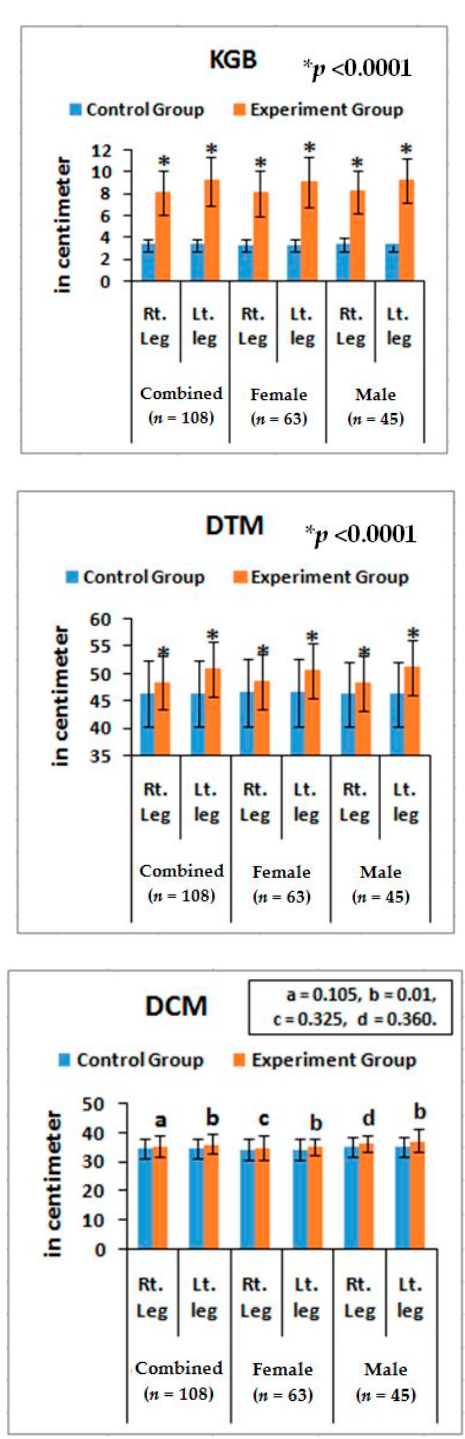
Figure 5. Graphical representation of anatomical features for KGB, DTM, and DCM in comparison with control and experimental groups and their p -values.